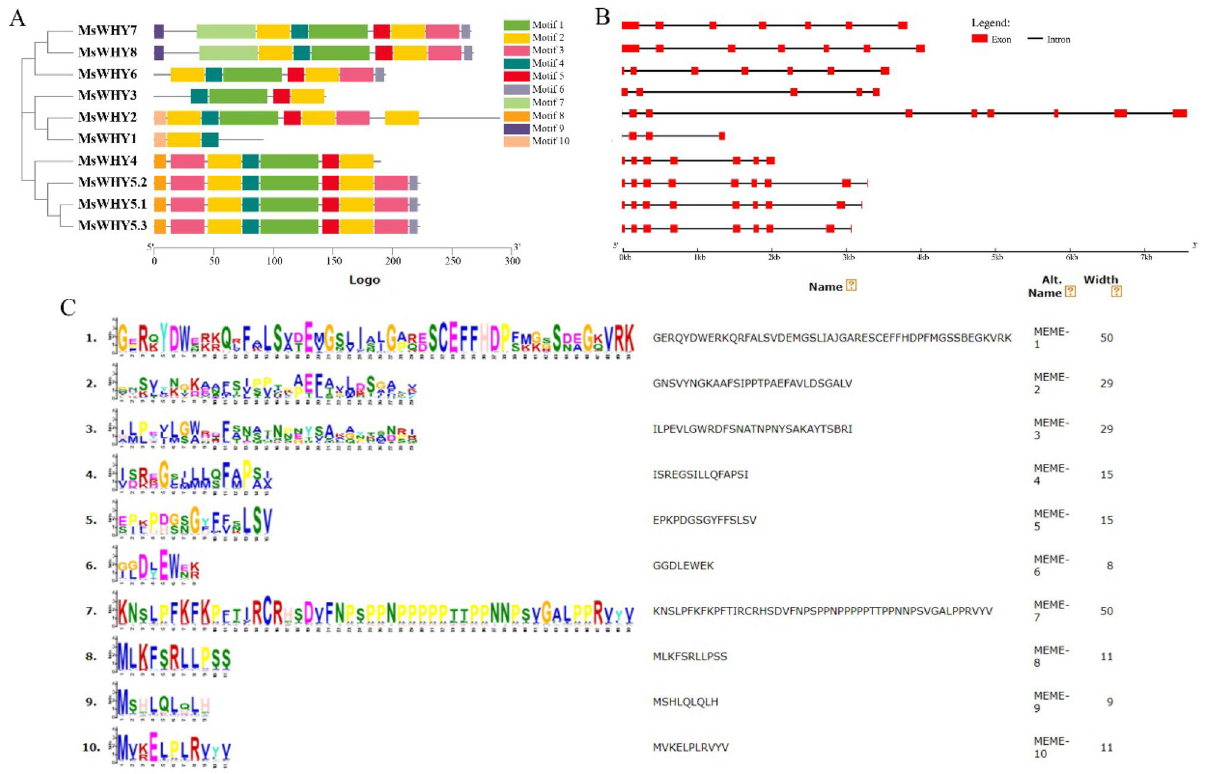
Figure 4. The gene structure and conserved motifs analysis of the MsWHY genes. ( A ): Colored boxes representing different conserved motifs having different sequences and sizes. ( B ): Exon–intron organization of the MsWHY genes. ( C ): Conserved motif. The overall height of each stack represents the degree of conservation at this position, while the height of the individual letters within each stack indicates the relative frequency of the corresponding amino